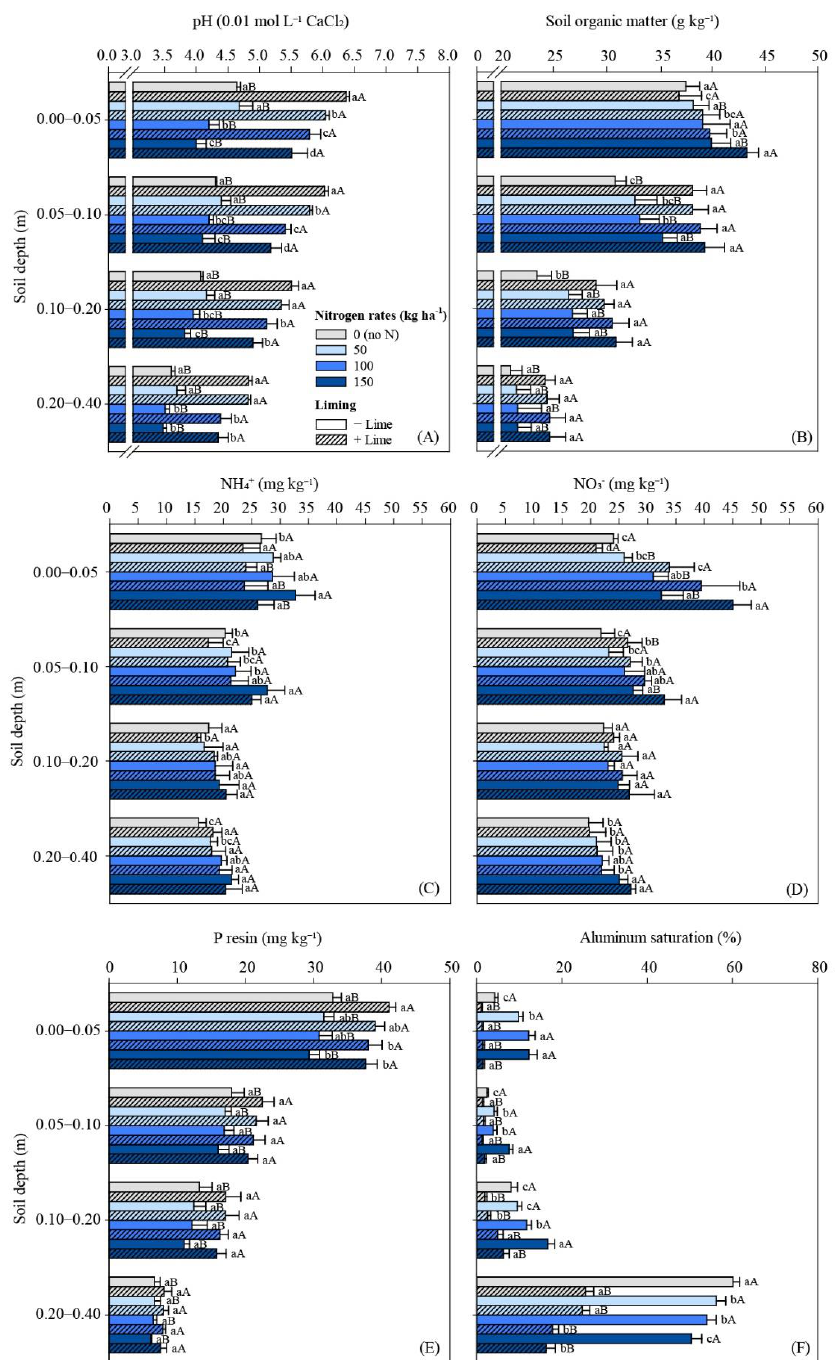
Figure 5. Changes in soil pH ( A ), soil organic matter (SOM) ( B ), NH 4 + ( C ), NO 3 − ( D ), phosphorus (Presin) ( E ), and aluminum saturation (AS) ( F ) under different treatments (0 (no N applied), 50, 100, and 150 kg N·ha – 1 × absence ( − Lime) and presence (+Lime) of lime application). Different lowercase and uppercase letters indicate significant differences between N rates and lime applications, respectively, by Student ’ s t -test at p ≤ 0.05. The error bars express the standard error of the mean ( n = 4).